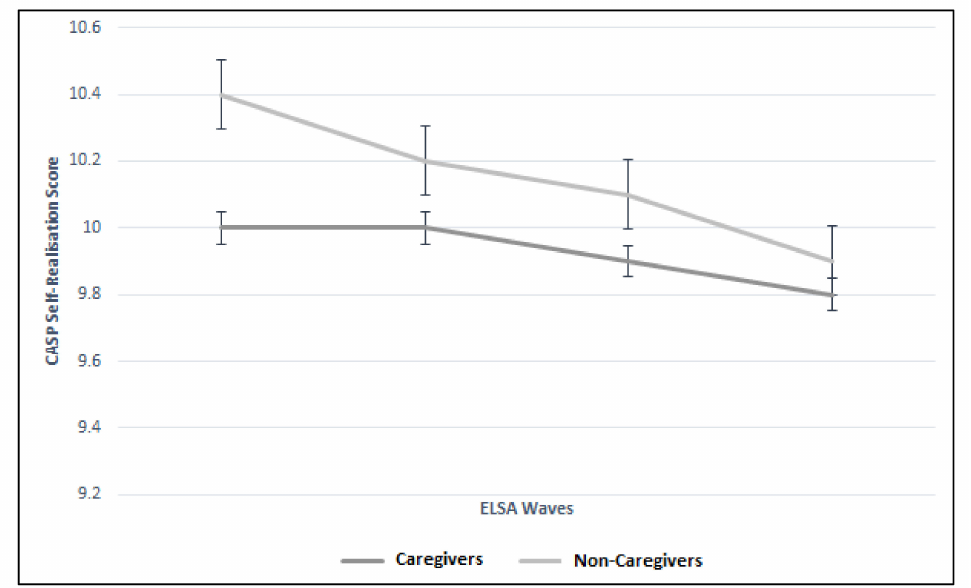
Figure 7. Trajectory of self-realization CASP score between caregiver and non-caregiver cohorts across four ELSA